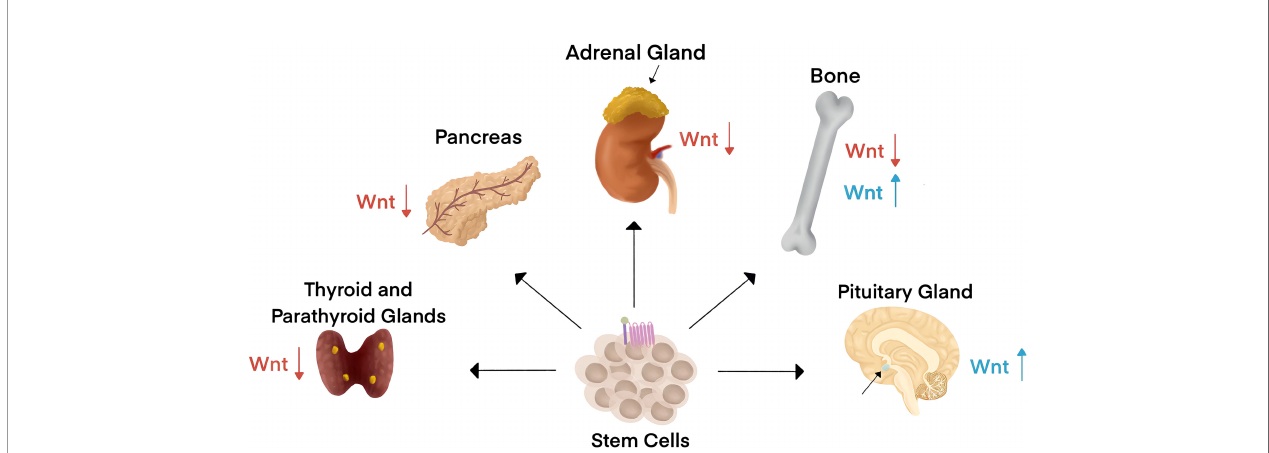
FIGURE 2 | Canonical Wnt signaling impacts endocrine organ physiology and pathology. Wnt is the stem cell niche signal across endocrine organs. Endocrine systems are designated by the criteria of hormone secretion into the blood to affect changes in distant organs. Wnt signaling has been associated with endocrine disorders in the thyroid, parathyroid, pancreas, adrenal gland, bone, and the pituitary gland. Wnt signaling activity is typically downregulated (red arrows) in diseases associated with all endocrine organs except for the pituitary gland and in some bone-associated endocrine disorders, where Wnt signaling activity is upregulated (blue